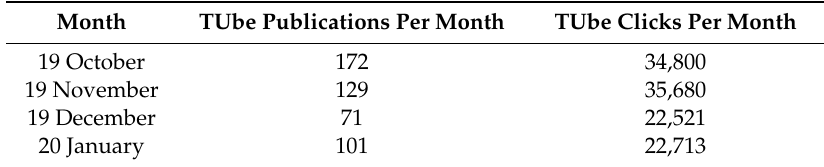
Table 3. Publications and clicks at the video portal TUbe in winter semester 2019/2020. Source: Graz University of Technology, Educational Technology.